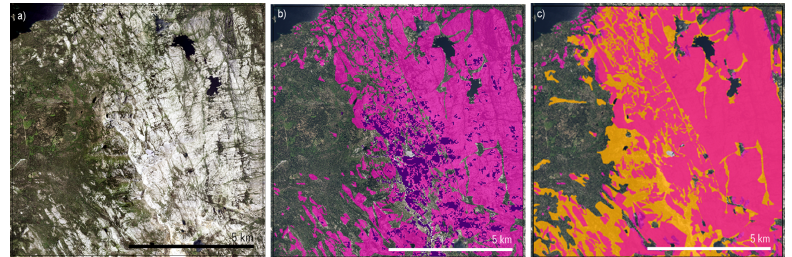
Figure 1. Comparison of hand-mapped bedrock outcrops (pink) to existing databases. ( a ) Location in the Sierra Nevada Mountains with exposed granite (bright areas), ( b ) showing bedrock is underestimated using the 2001–2011 NLCD “barren” class (purple), and ( c ) overestimated using NRCS soil survey units that are classified as >=50% “rock outcrops” (orange). This comparison illustrates that much improvement could be made to existing soil and land cover maps if remote sensing-based manual mapping could be